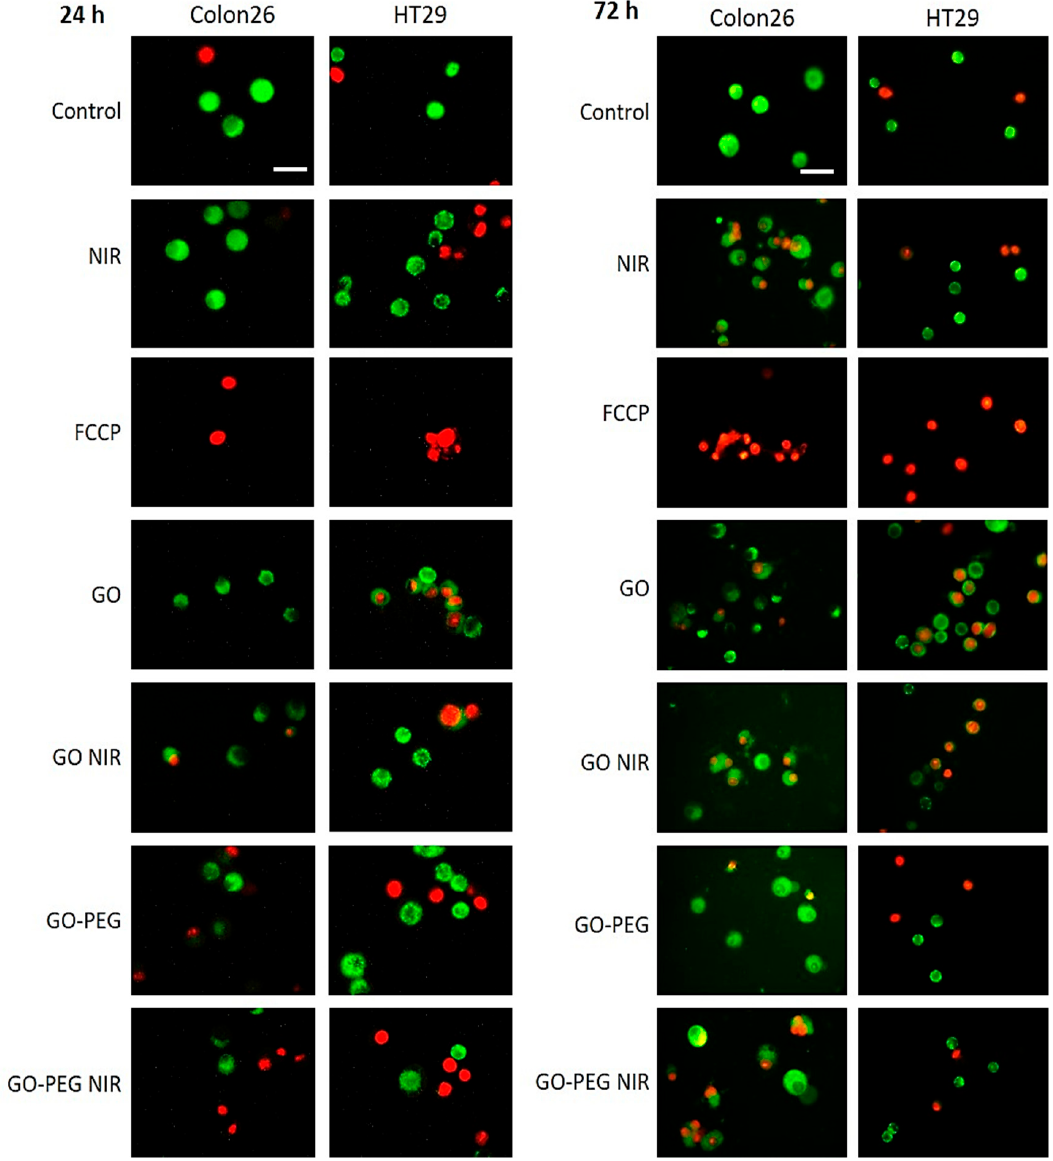
Figure 8. Fluorescent microscopy of mitochondrial morphology in Colon26 and HT29 cells incubated with GO and GO–PEG with and without NIR irradiation. Cells were stained with Rh123 at the two tested time points, 24 h and 72 h, and were visualized under an epifluorescent microscope. Representative epifluorescence images after staining with Rh123 and PI are displayed. Viable cells are green, whereas dead cells are red, due to accumulation of Rh123 and PI, respectively. White bars stand for 100 μ m.